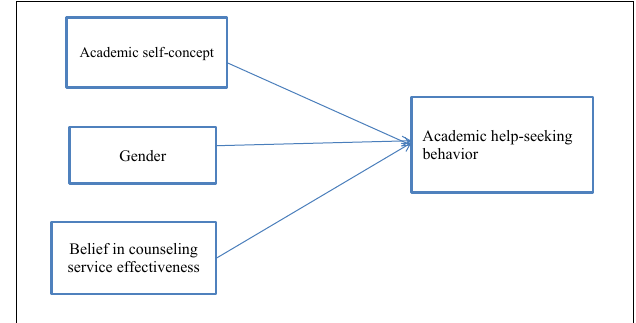
FIGURE 1 | Conceptual